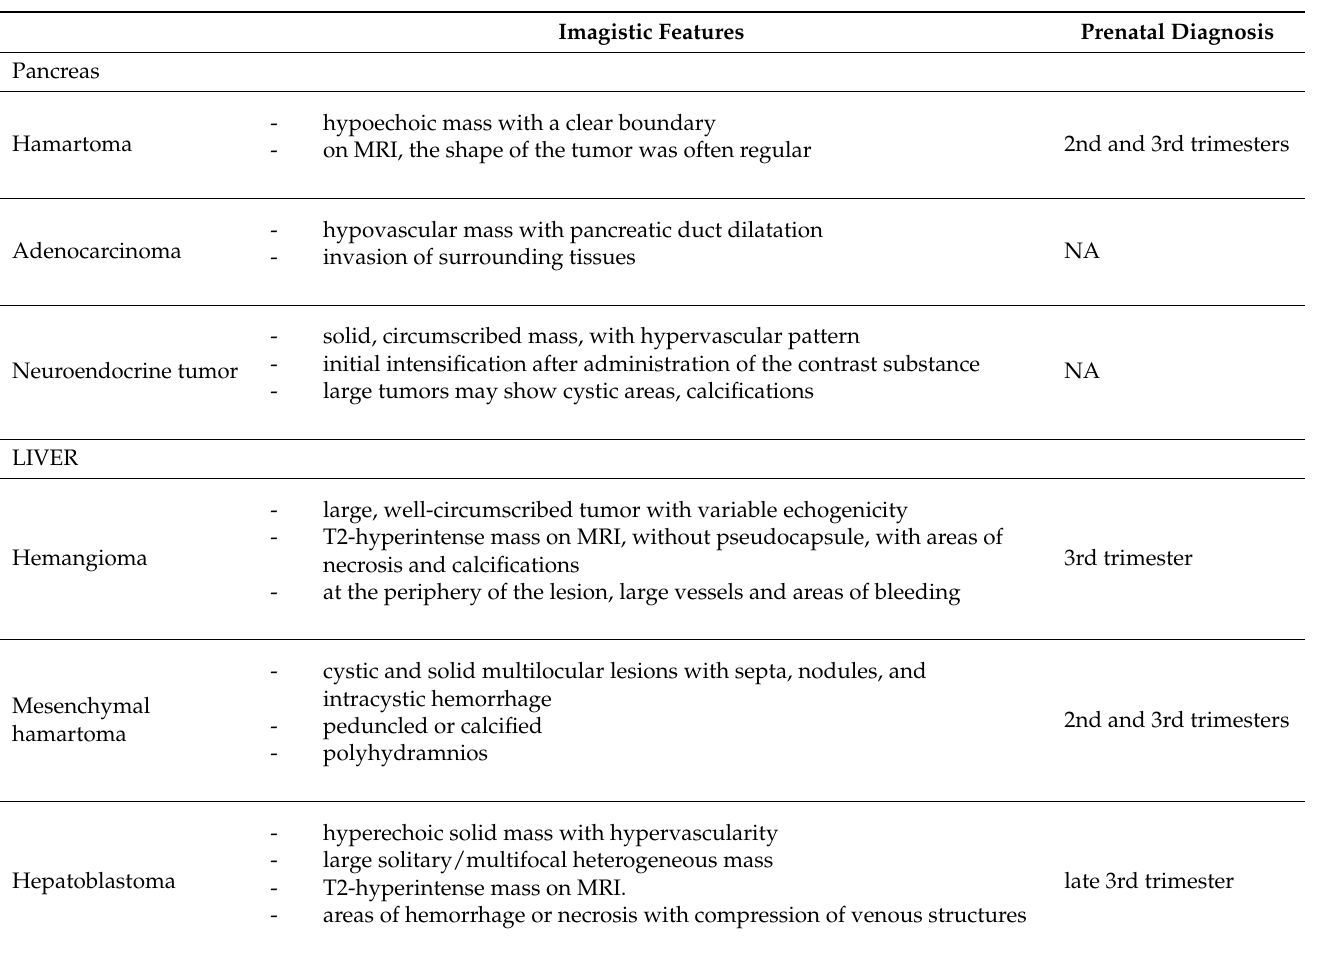
Table 5. Synopsis of imagistic evaluation of fetal pancreatic and liver tumors. Adapted from Birkemeier, K.L. (2020)